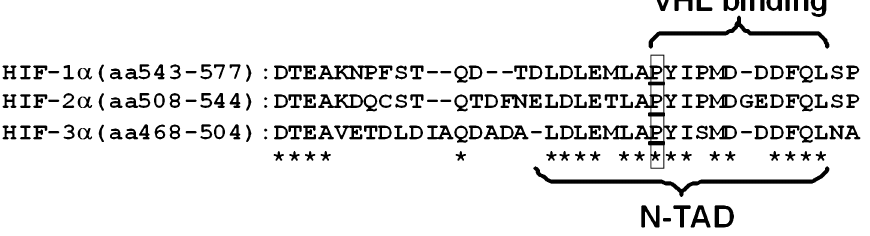
Fig. 1. Schematic representation of the minimal binding site of VHH-AG2 to HIF. HIF-1 α (aa543-577), HIF-2 α (aa508-544) and HIF-3 α (aa468-504). Identical residues are shown with asterisk. Indicated are residues defining the N-TAD and residues important for pVHL binding. The regulatory hydroxy-proline is boxed.